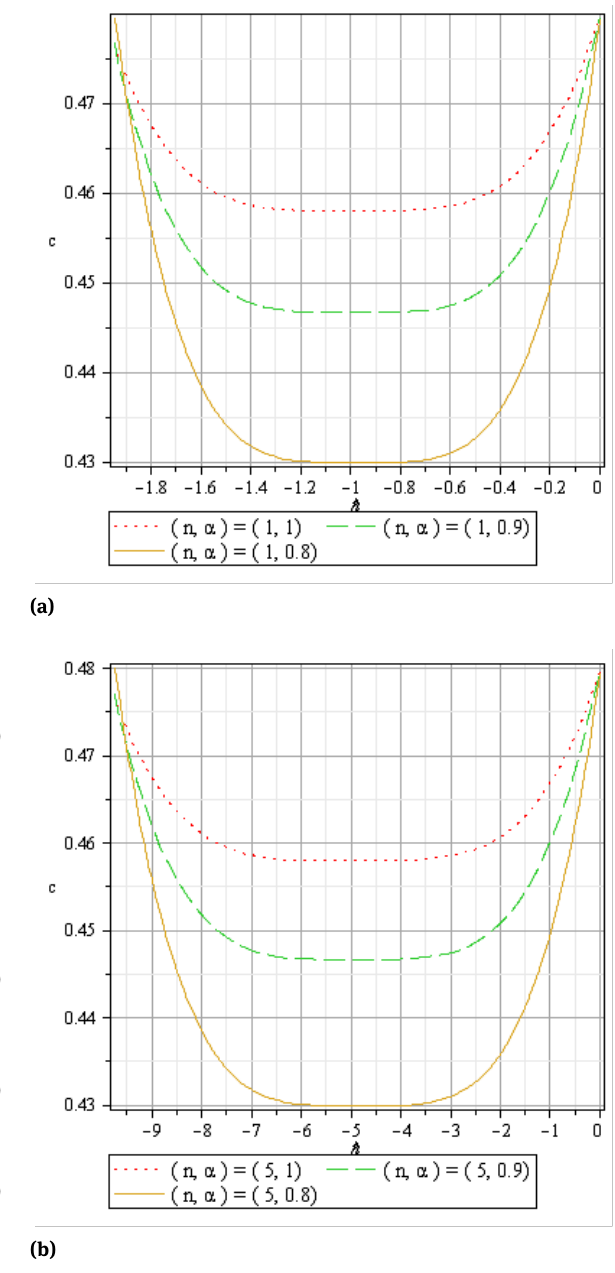
Fig. 3: (cid:126) -curves for fourth order approximation q -FHATM solution of Eq. (22) for different value of α ; (a) when n = 1 , (b) or n = 5 .